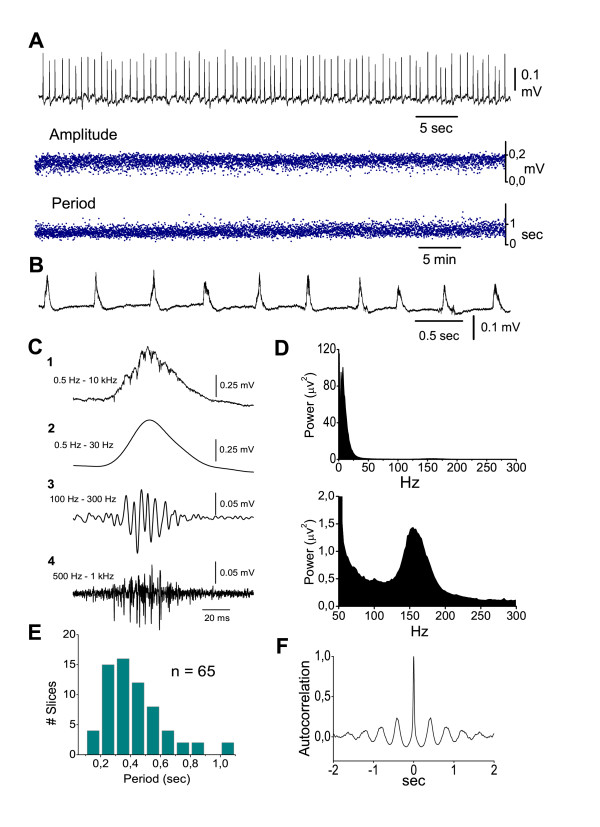
In vitro SPW-R activity recorded in the st. pyramidale of CA1 region of ventral hippocampal slices perfused with standard medium. A. Continuous long-lasting field recording of SPWs (trace on the top, low-pass filtered at 35 Hz) and the corresponding time histograms of amplitude (middle) and period (bottom). Data were obtained from a slice four hours after its placement on the recording chamber. Note the persistency and stability over time of both characteristics of SPWs. B. Record of spontaneous activity obtained from a different slice, presented at a faster sweep speed. C. A wide band record of a single SPW-R event (C1) and the filtered sweeps are shown, illustrating the distinct components of the event. Low-pass (0.5–30 Hz) and band-pass (100–300 Hz) filtering reveals the slow wave (C2) and the associated ripple oscillation (C3) respectively. Band-pass filtering at very high frequencies (0.5–1 kHz, C4) discloses the burst-like multiunit activity occurring mostly during the rising and peaking phases of the slow positive potential. D. FFT from 1 min raw record of spontaneous activity showing the difference in power between SPWs (upper diagram) and ripples (lower diagram, same power spectrum shown at a greater magnification). SPW dominant peak is at 5–10 Hz. Ripple activity is at ~150 Hz. E. Histogram of period (inter-event interval) of SPWs calculated from a population of slices, showing that most of the slices displayed a period between 0.2–0.6 sec, which correspond to a frequency range of 1.5–5.0 Hz. F. Auto-correlogram from a 5 min low-pass record from a distinct experiment, showing the typical degree of rhythmicity of SPWs.